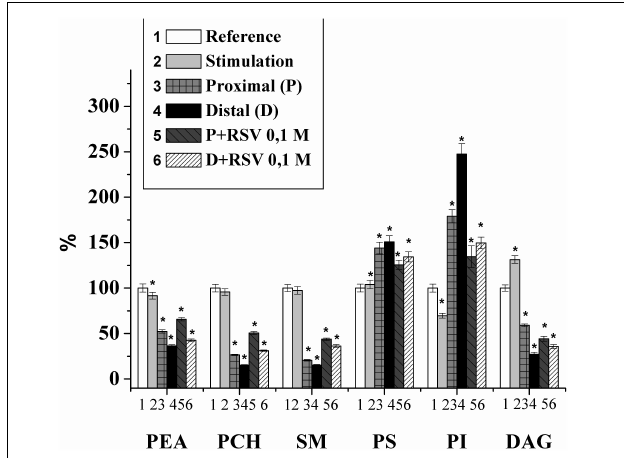
FIGURE 1 | Changes of the individual lipid fraction contents during the stimulation and damage of the rat myelin nerve and the action of resveratrol (RSV, 10 − 1 M) (% of control); ∗ significance of difference in relation to control, p <